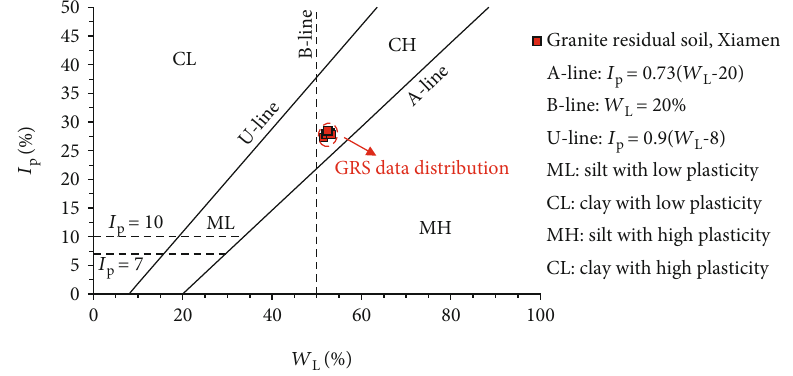
Figure 2: Casagrande plasticity chart of